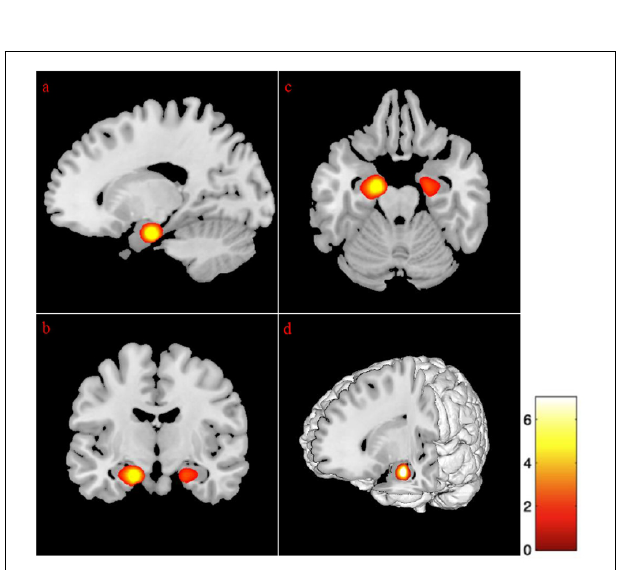
FIGURE 3 | Regression between gray matter regions, depression, and advancing age. The position of the axes indicates a negative correlation between the right superior frontal gyrus medial segment (MNI coordinates: 6, 42, 21), advancing age, and depression. Color bar indicates the t -score for the regression slopes. (A) Sagittal plane, (B) coronal plane, (C) axial plane, and (D) 3D illustration, p =